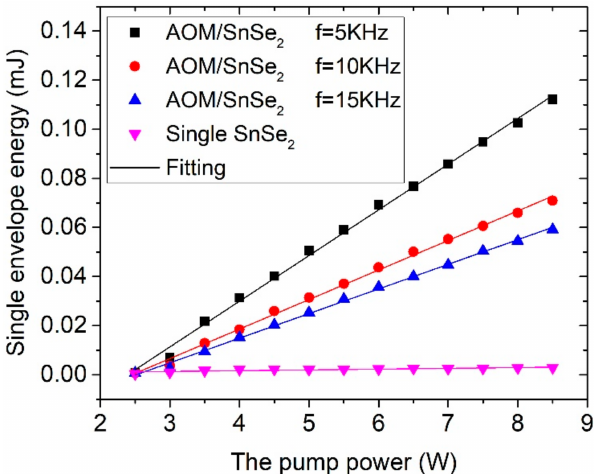
Figure 5. Variation of the single envelope energy with the pump power for QML lasers with different modulation